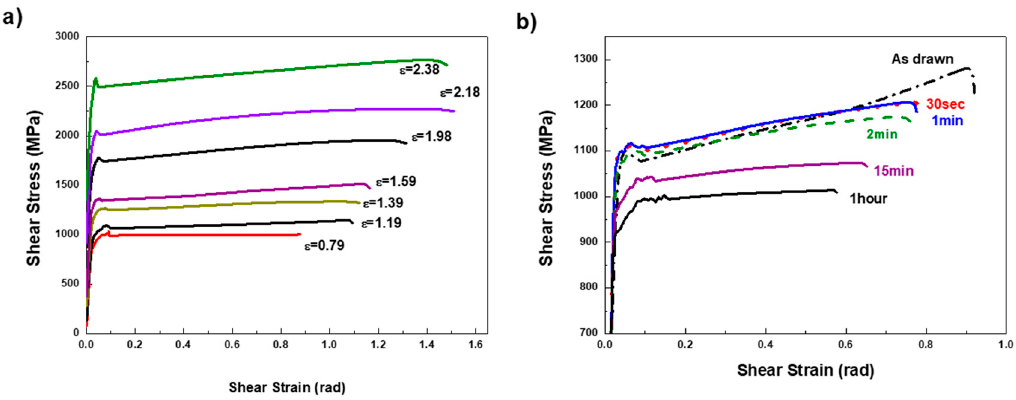
Figure 6. Shear stress–shear strain curves of steel wires ( a ) cold drawn with different drawing strains, ( b ) cold drawn with ε = 1.95 and annealed at 500 °C with different annealing time.